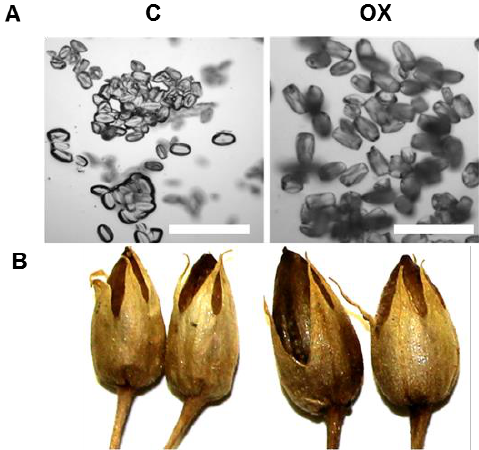
Figure 2. Comparison of pollen and fruit from control (C) and transgenic tobacco (OX) plants that express Solanum lycopersicum PI3K (PI3K-GFP). Panel A : Microscopic observation of pollen from control and OX flowers, Scale represent 100 µm, Panel B : Fruit from control and transgenic tobacco (OX) plants.